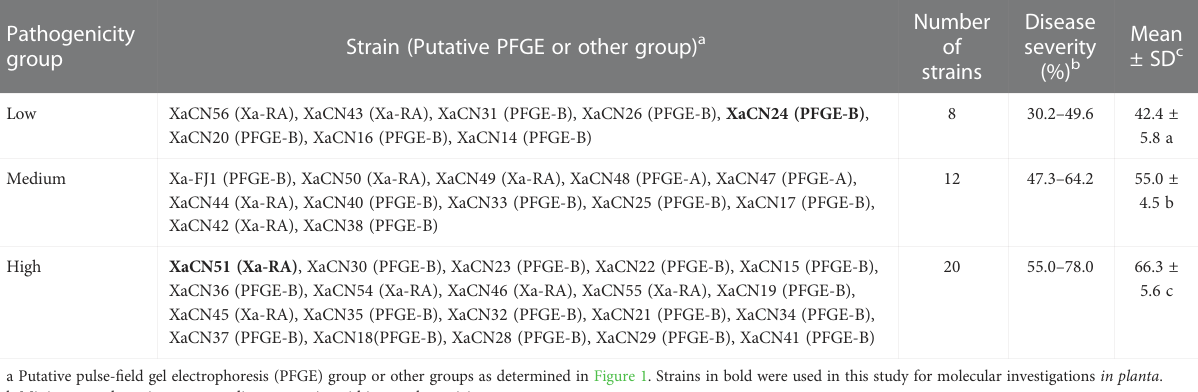
TABLE 2 Distribution of 40 strains of Xanthomonas albilineans in different pathogenicity groups based on disease severity of sugarcane stalks 28 days post